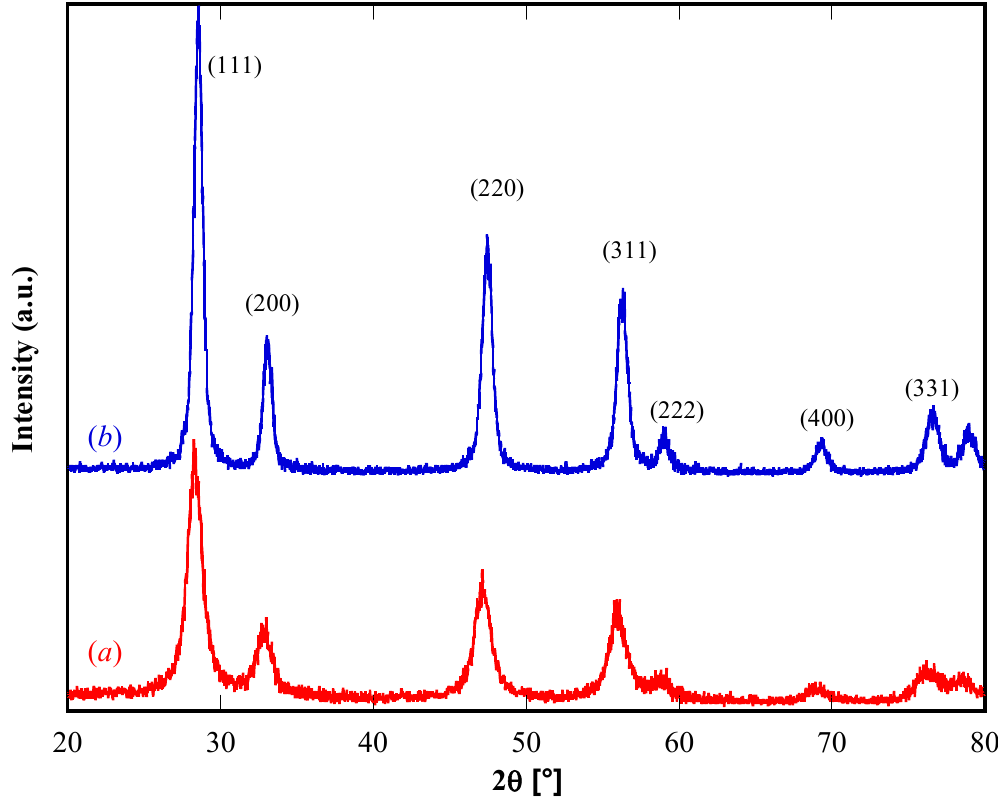
Figure 2. XRD patterns of as-synthesized (red) and calcined (blue) SPDC-NH3.